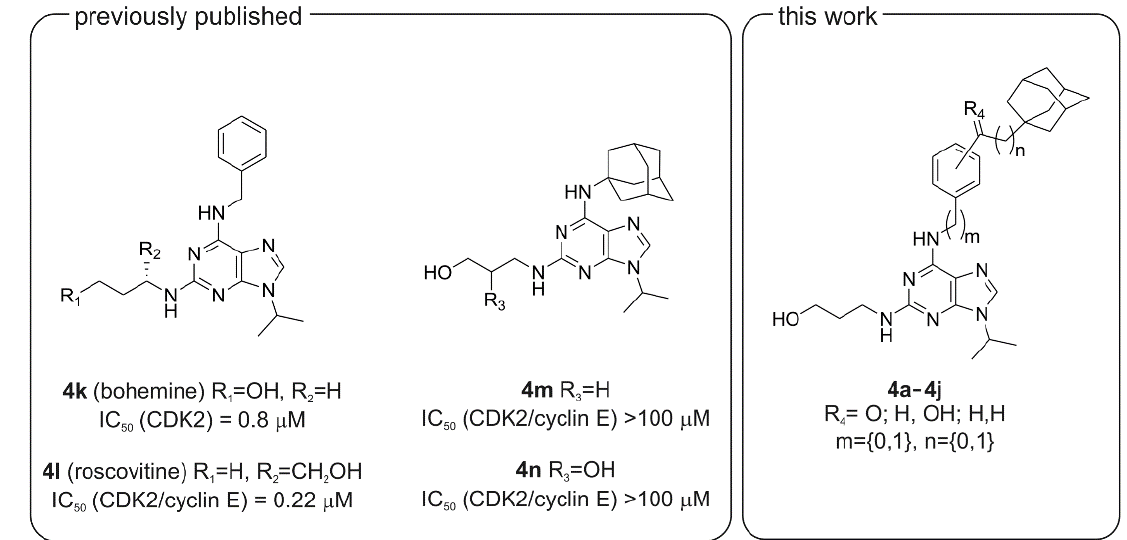
Figure 1. Purine derivatives considered in this work. The inhibitory concentration values (IC 50 ) are taken from previously published papers ( 4k [14]; 4l [15]; 4m , 4n [14,16]).